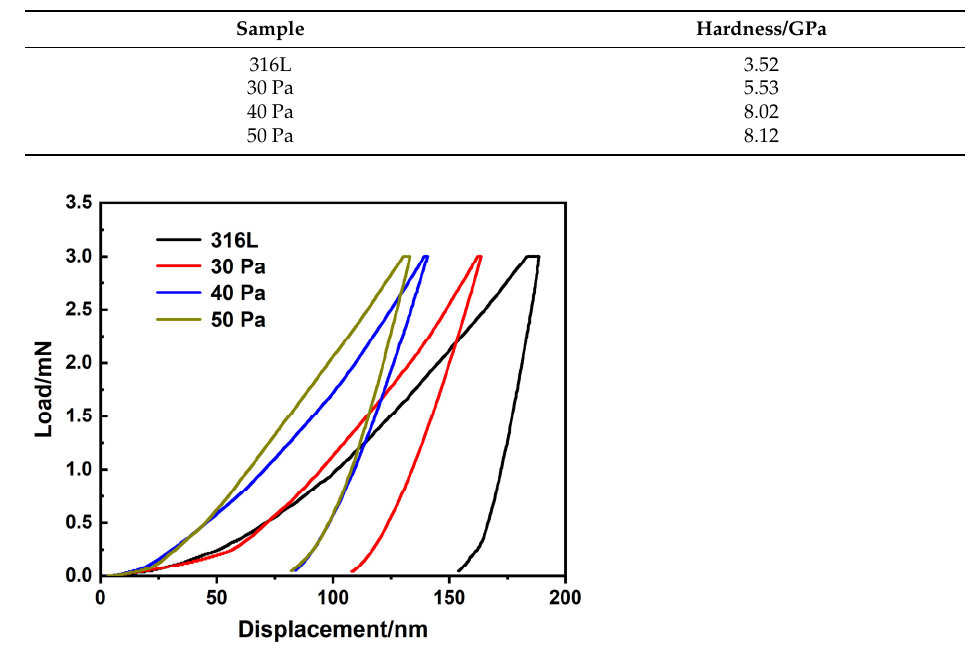
Figure 7. ( a ) Surface water contact angle and ( b ) UV reflectance of Nb ‐ Zr alloying layers prepared at pressures of 30 Pa, 40 Pa, and 50 Pa.